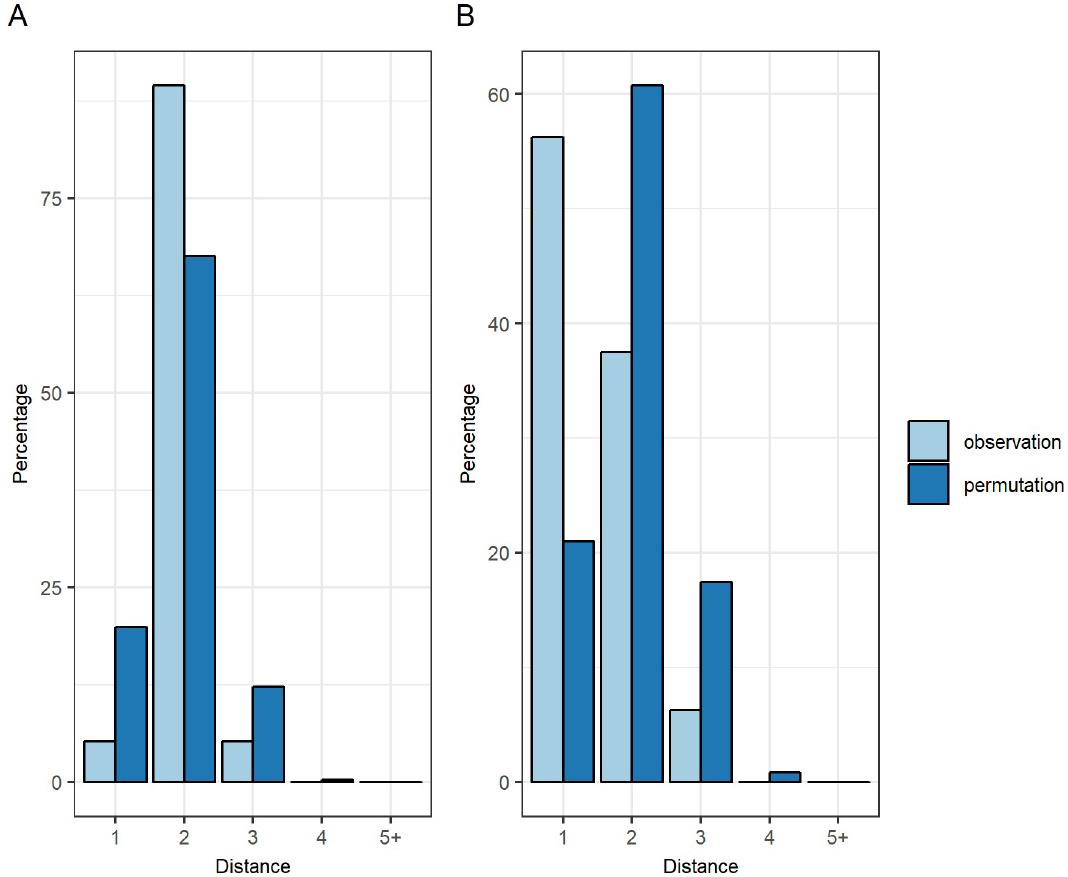
Fig 1. Distribution of distances between acquisition cases and their closest potential infector. Comparison between observed data (light blue) and random permutated data (dark blue). For each incident-colonisation case, potential infectors were selected as the closest in the CPI-network of all candidates sharing the most similar isolate as the case in the preceding 4 weeks. (A) ESBL-EC distribution. (B) ESBL-KP distribution. Here distance is the number of edges between two individuals in the